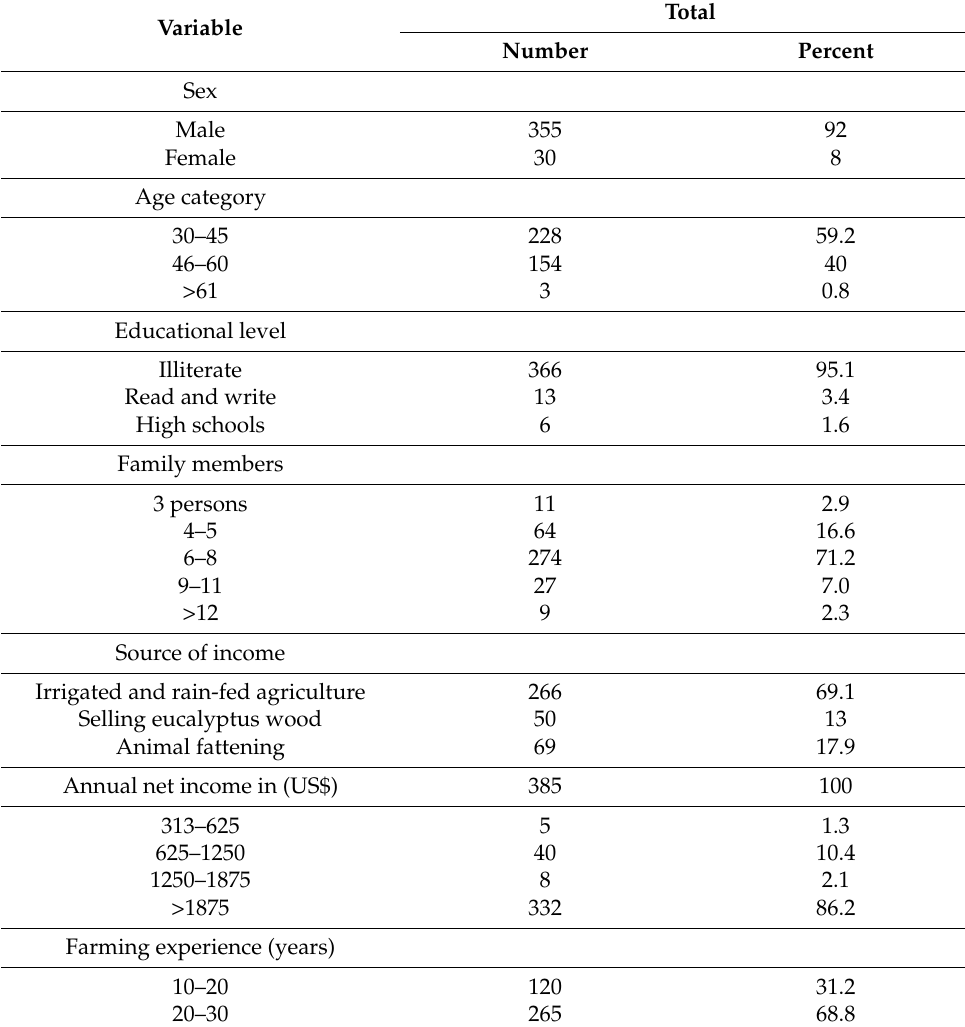
Table 3. Respondents demographic and socio-economic